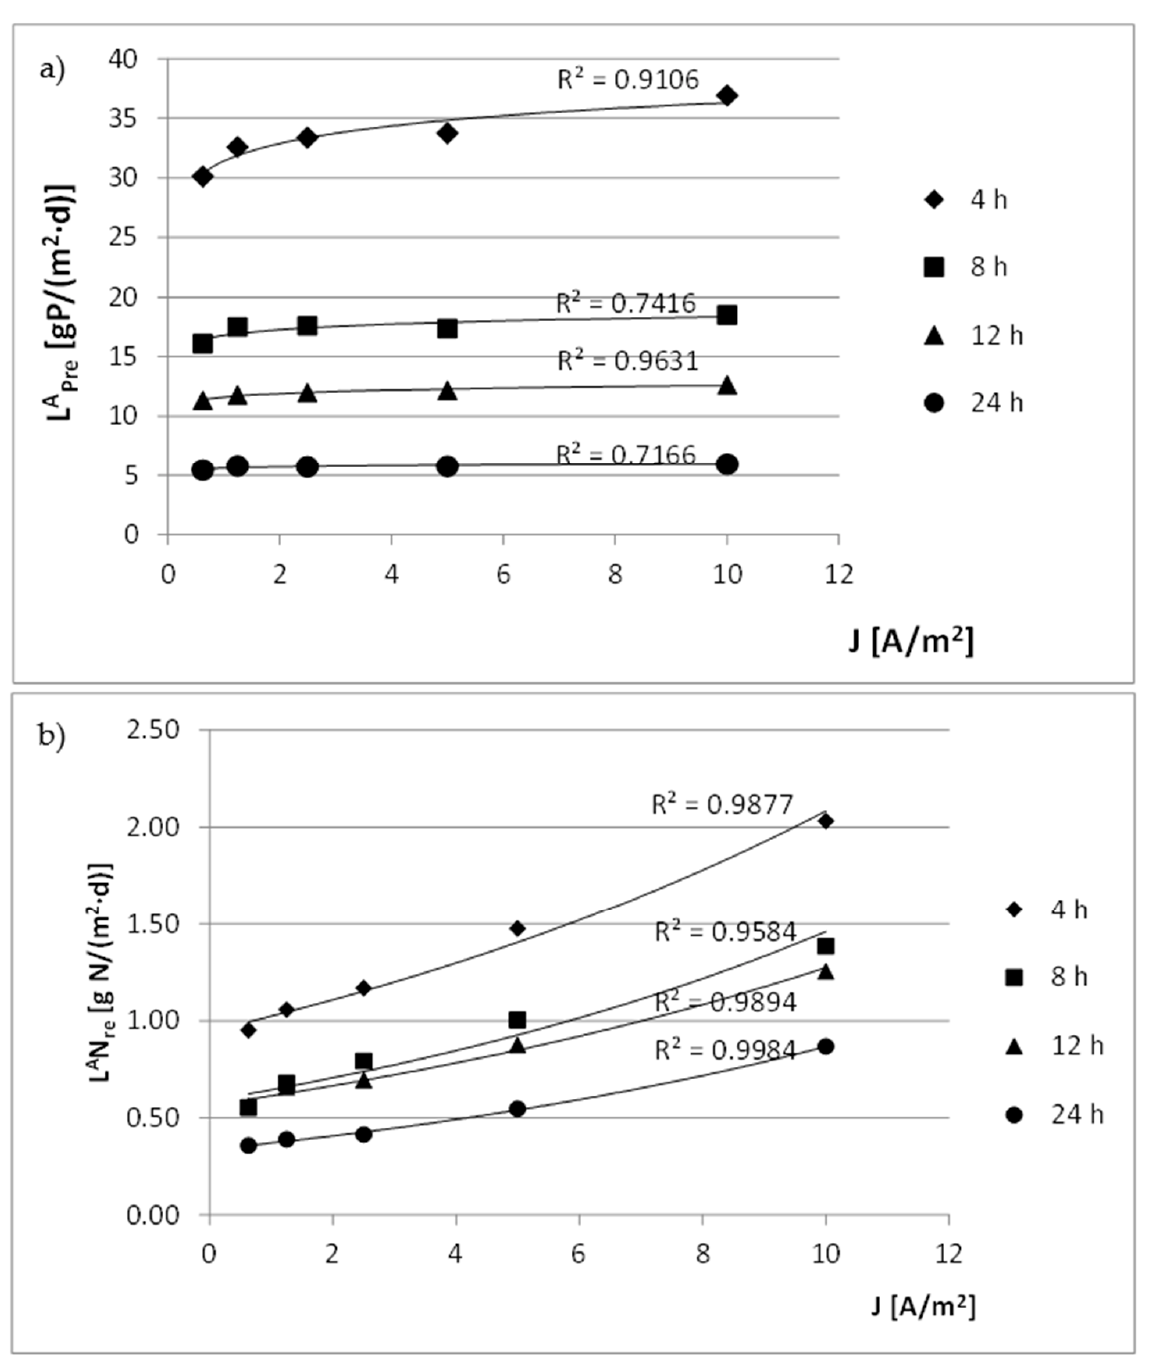
Figure 2. The influence of current density and HRT on the removed load (L A ) per day in the electrochemical rotating disc contactor (RECDC): ( a ) Phosphorus (L A P re ); ( b ) total nitrogen (L A N re ).